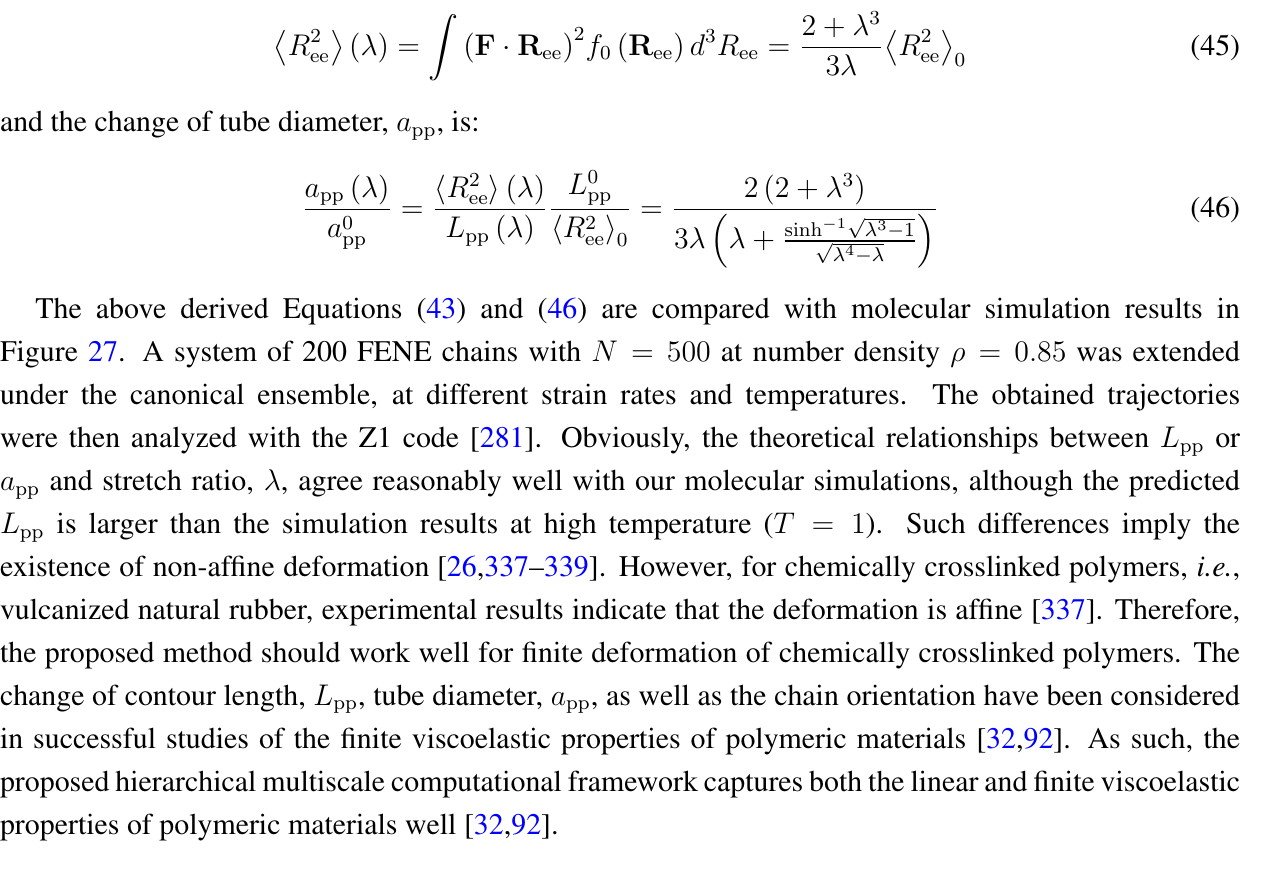
Figure 27. Uniaxial tension effect on ( a ) PP length, L FENE chains with length N = 500 . The dashed lines are given by Equations (43) and